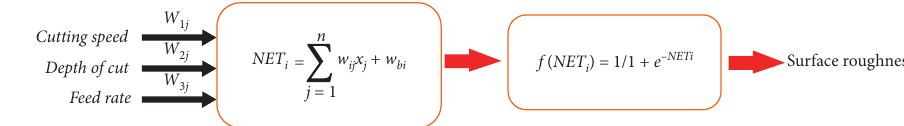
Figure 1: Network structure for the surface